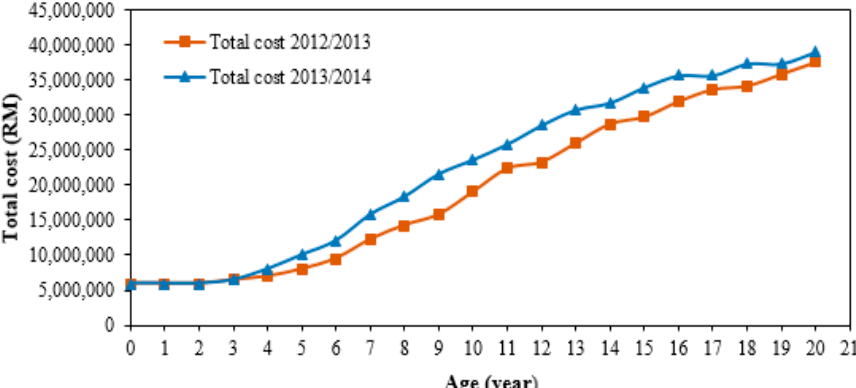
Figure 11. Maintenance cost for transformers in each state for transition states for the year 2012/2013.